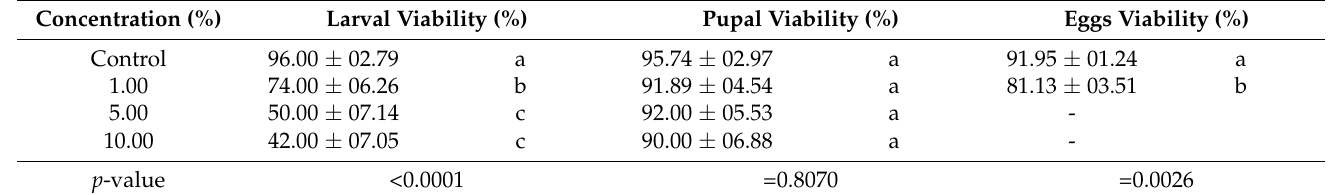
Table 2. Parametric ranking using the binomial model with survival (mean ± SE) of the P.